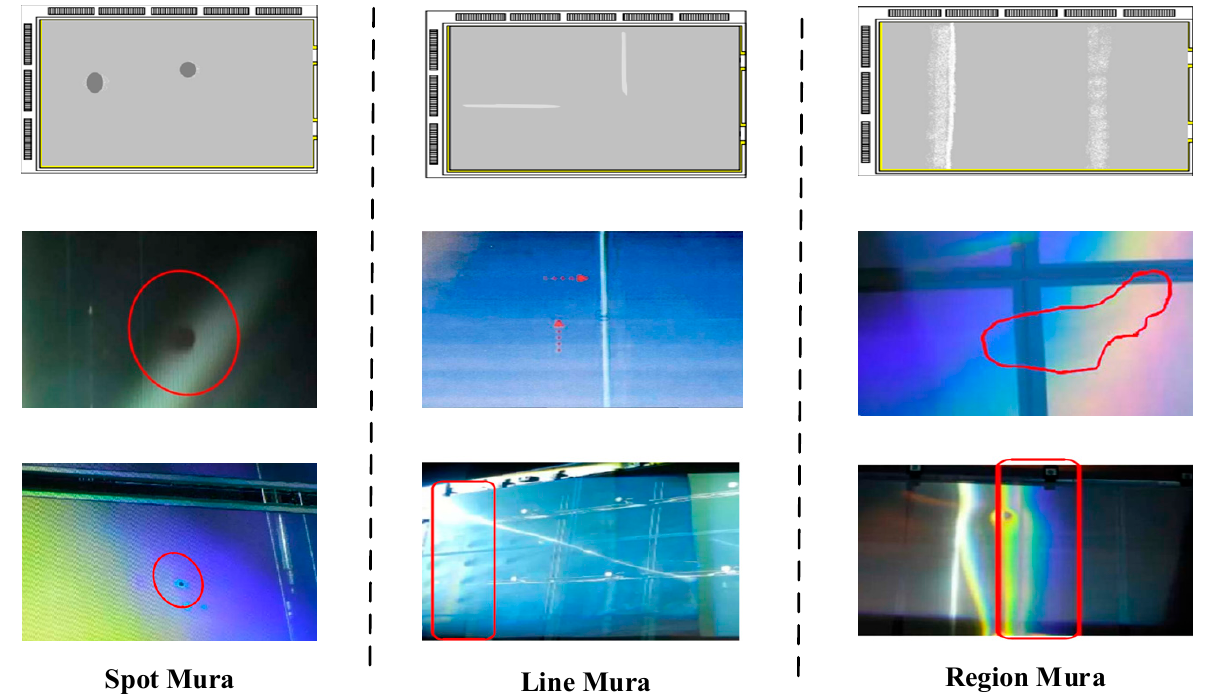
Figure 5. Schematic diagram of common Mura defects [3]. Reprinted with permission from ref. [3], Copyright 2017 Huazhong University of Science and